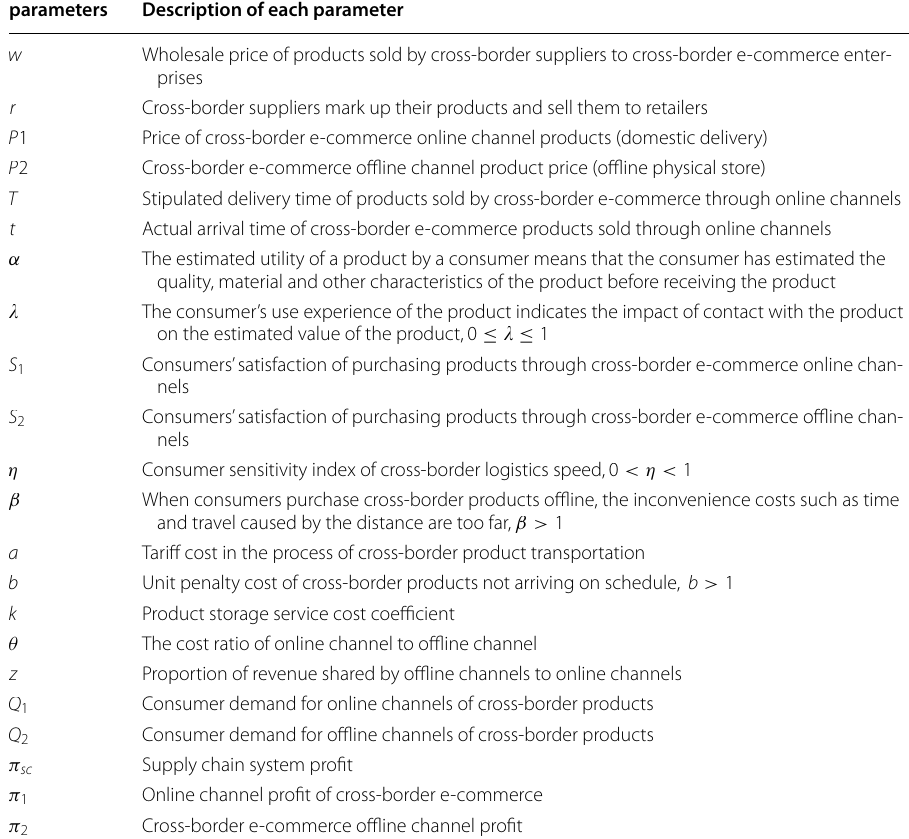
Table 1 Description of each parameter parameters Description of each